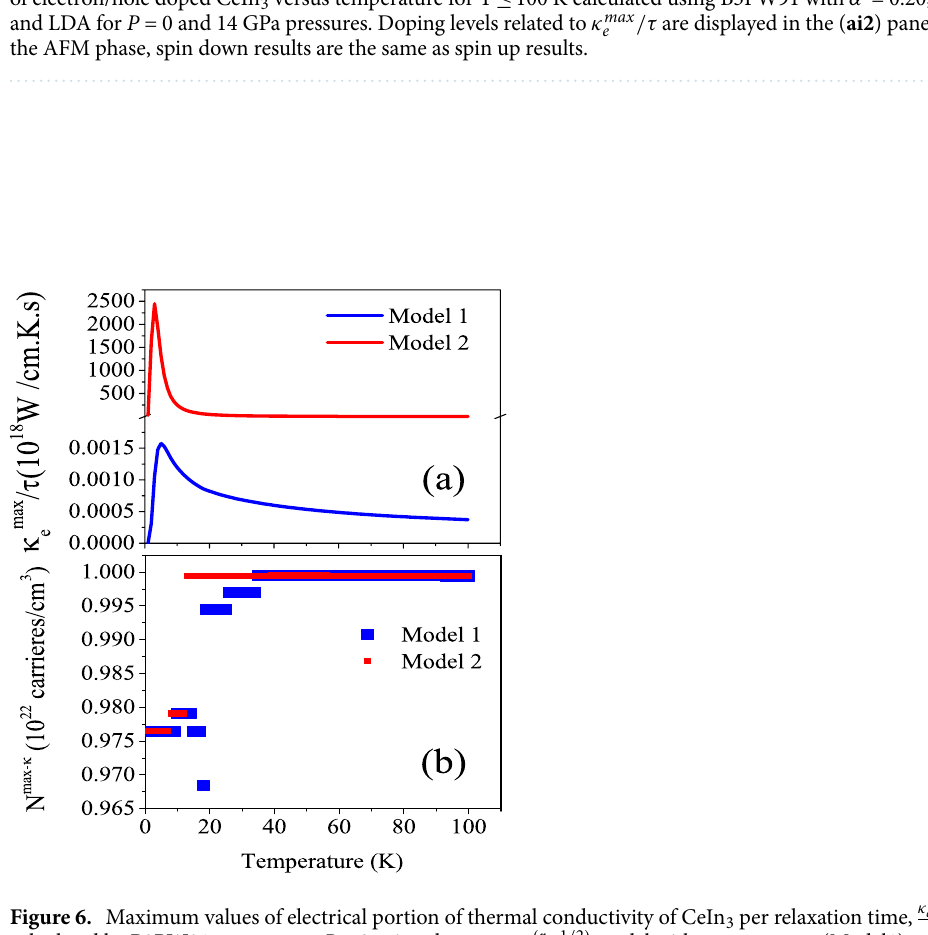
Figure 6. Maximum values of electrical portion of thermal conductivity of CeIn 3 per relaxation time, calculated by B3PW91- α = 0.20 at P = 0 using the τ = τ 0 ǫ ( r − 1 / 2 ) model with τ 0 = 5 , r = 2 (Model1) and r = 4 (Model2) for T (cid:31) 100 K temperature range. The related doping levels are displayed in the ( b )